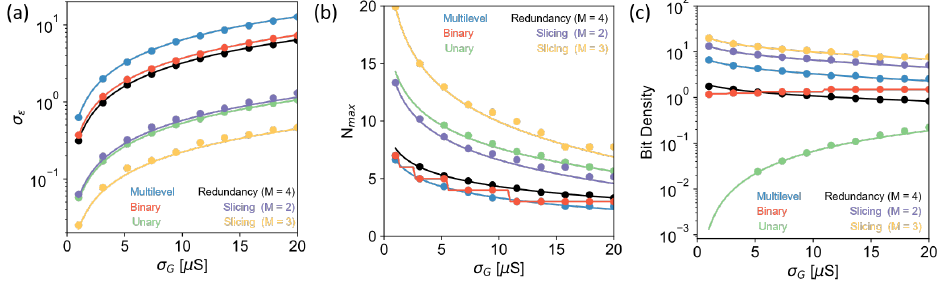
Figure 10. Figures of merit of various programming strategies. ( a ) Standard deviation of the overall programming error σ G as a function of the conductance error σ G assuming N = 7 bits. ( b ) Maximum number of bits N max as a function of the conductance error σ G considering a programming error σ (cid:101) = 1%. ( c ) Bit density as a function of the conductance error σ G . Adapted from [51].